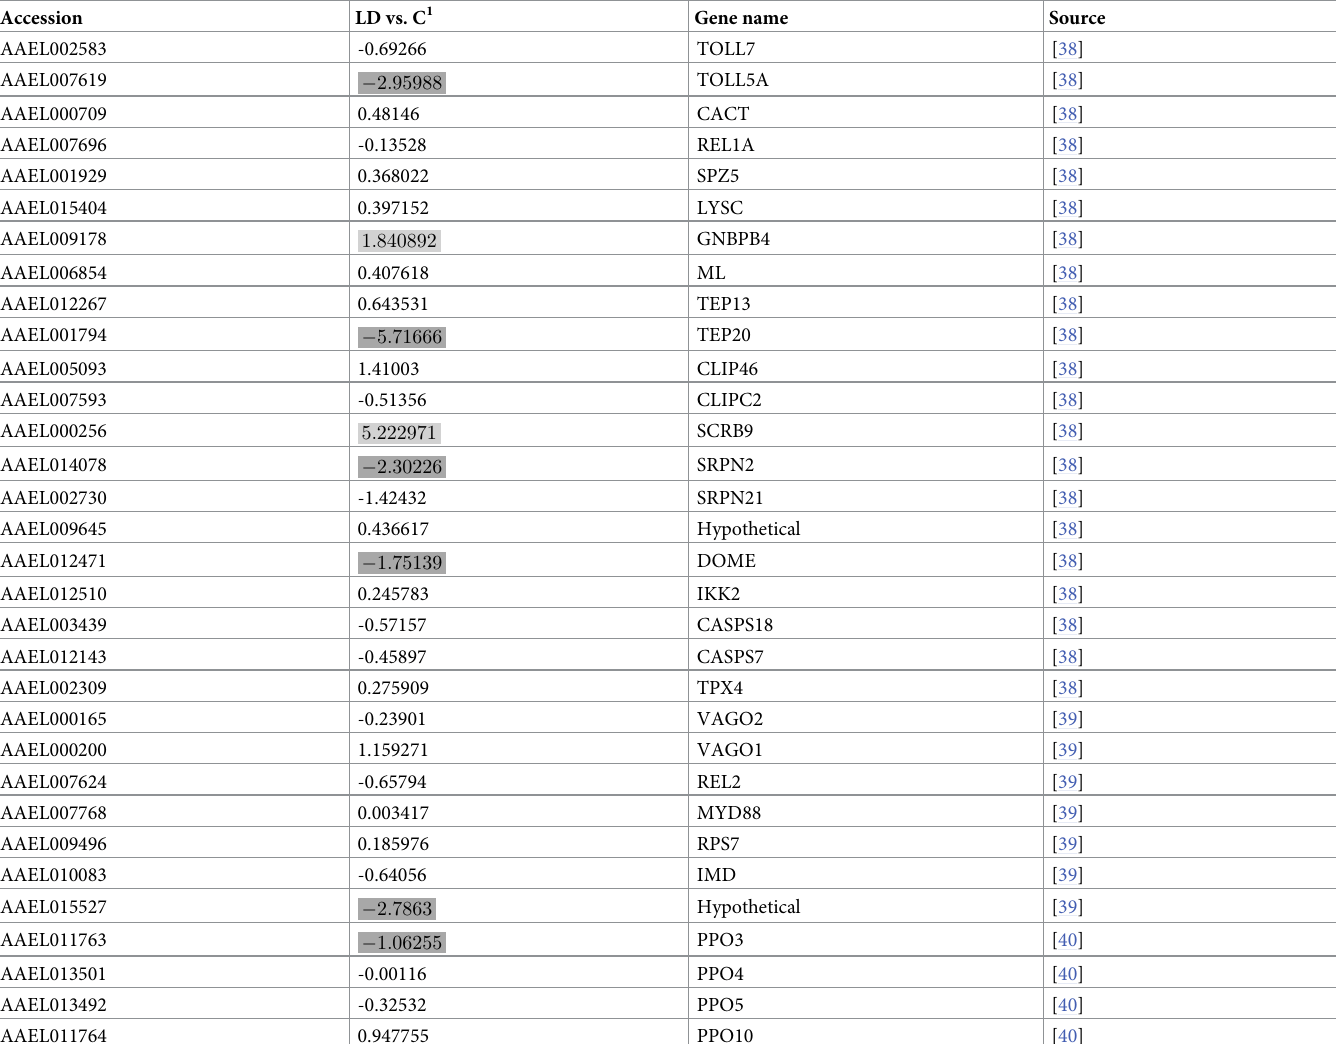
Table 1. Immunity gene expression during lipid